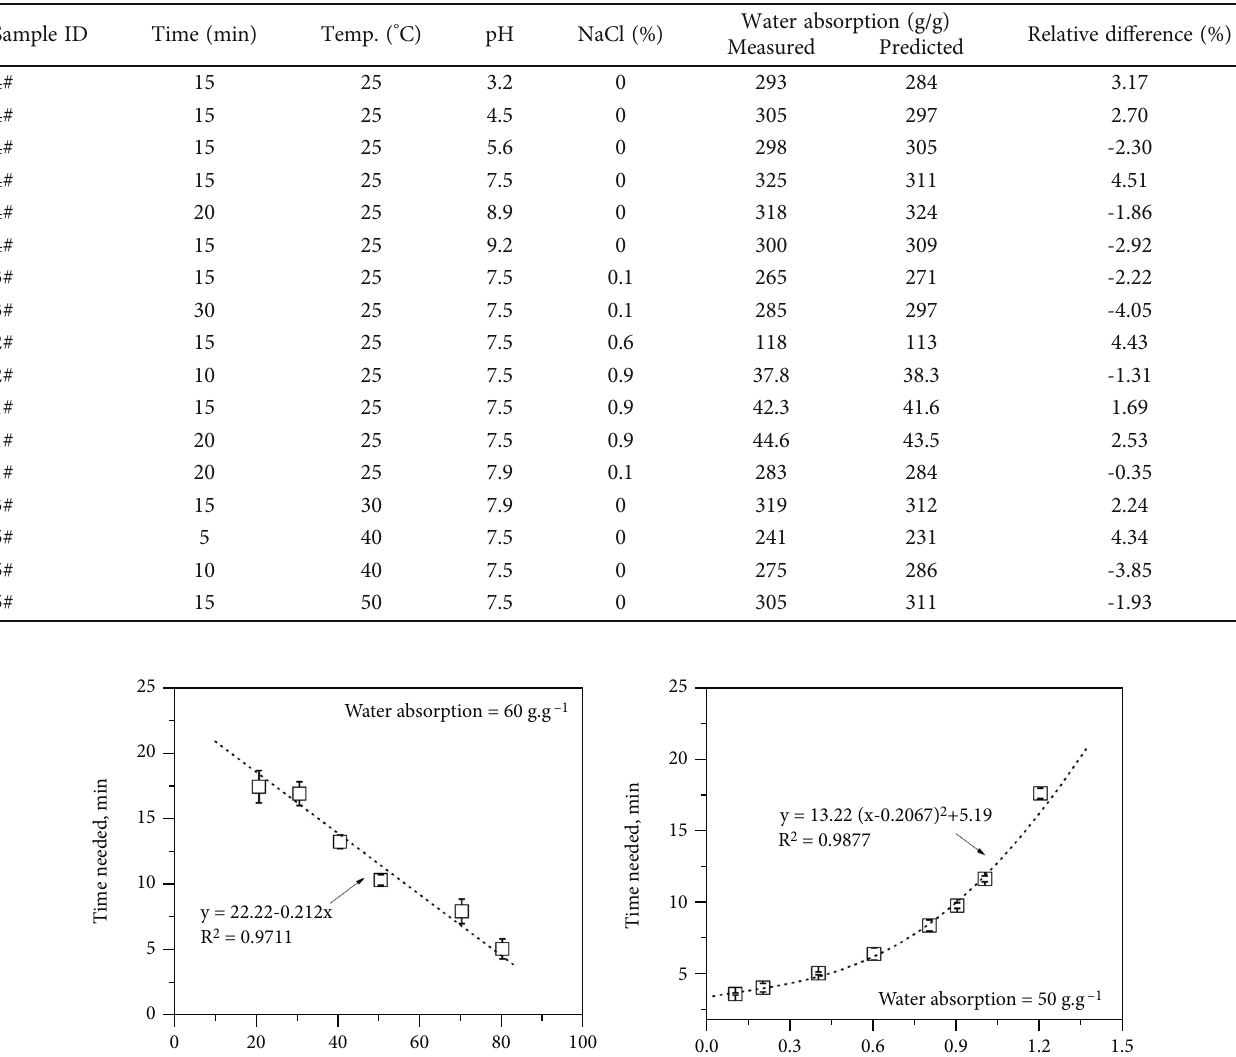
Table 4: Validation of the model.